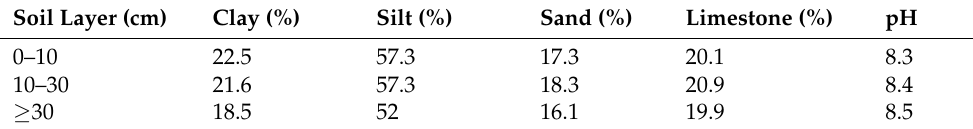
Table 2. Soil properties at the experimental fields in 2010 and 2011 before